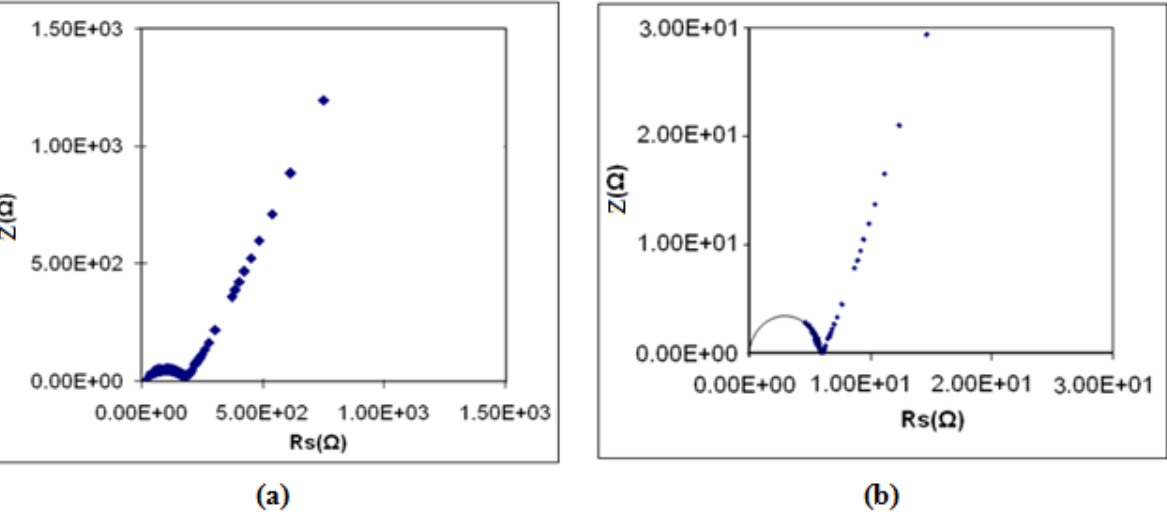
Table 2. Conductivity of PEMA-NH